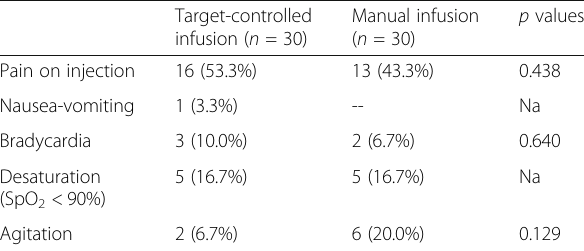
Table 5 Incidences of perioperative side